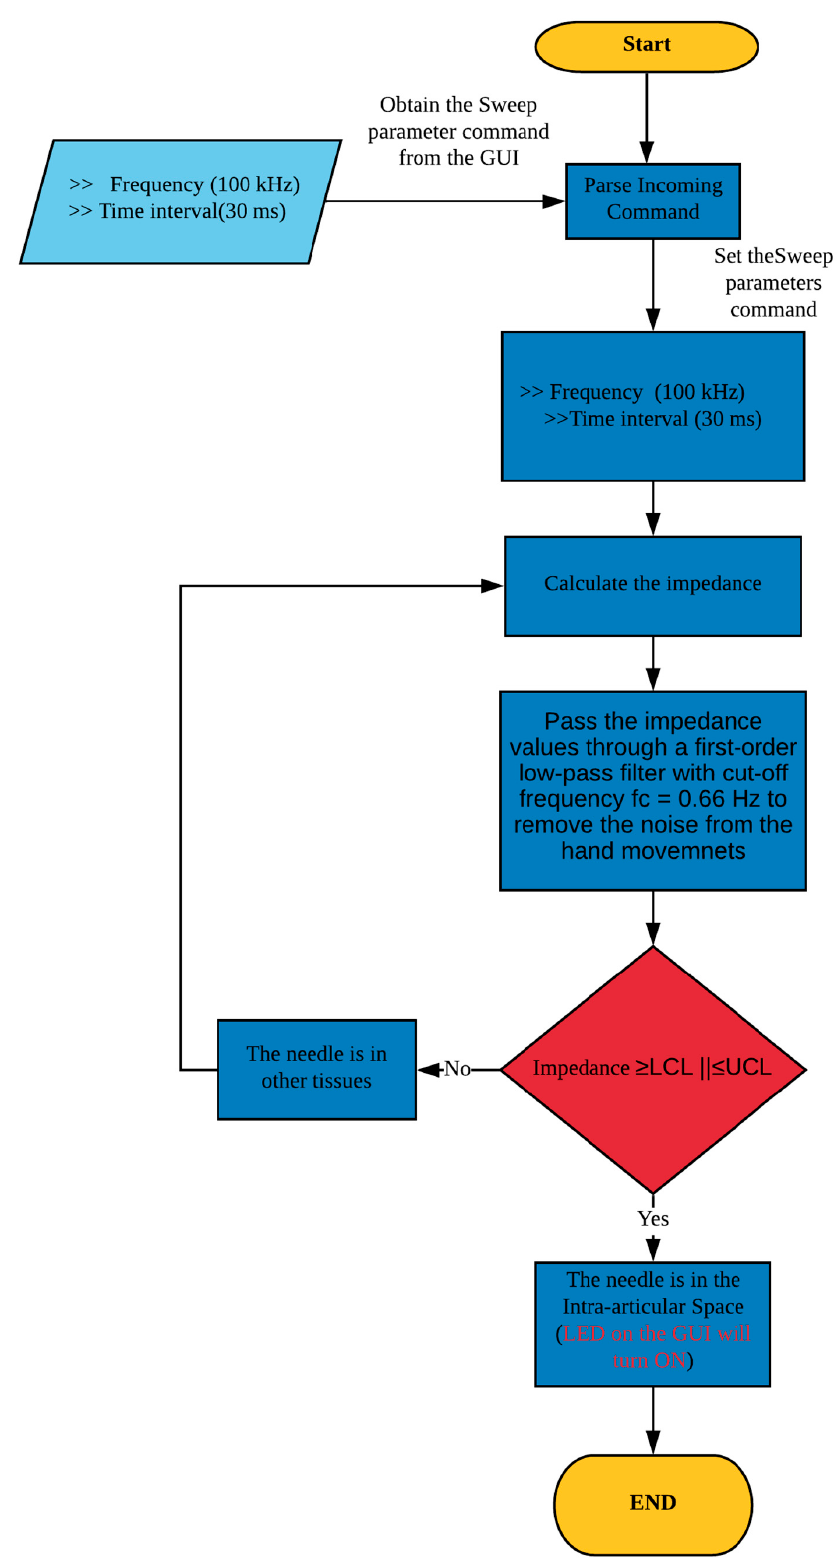
Figure 3. Flow diagram for detecting the needle tip in the intra-articular space.